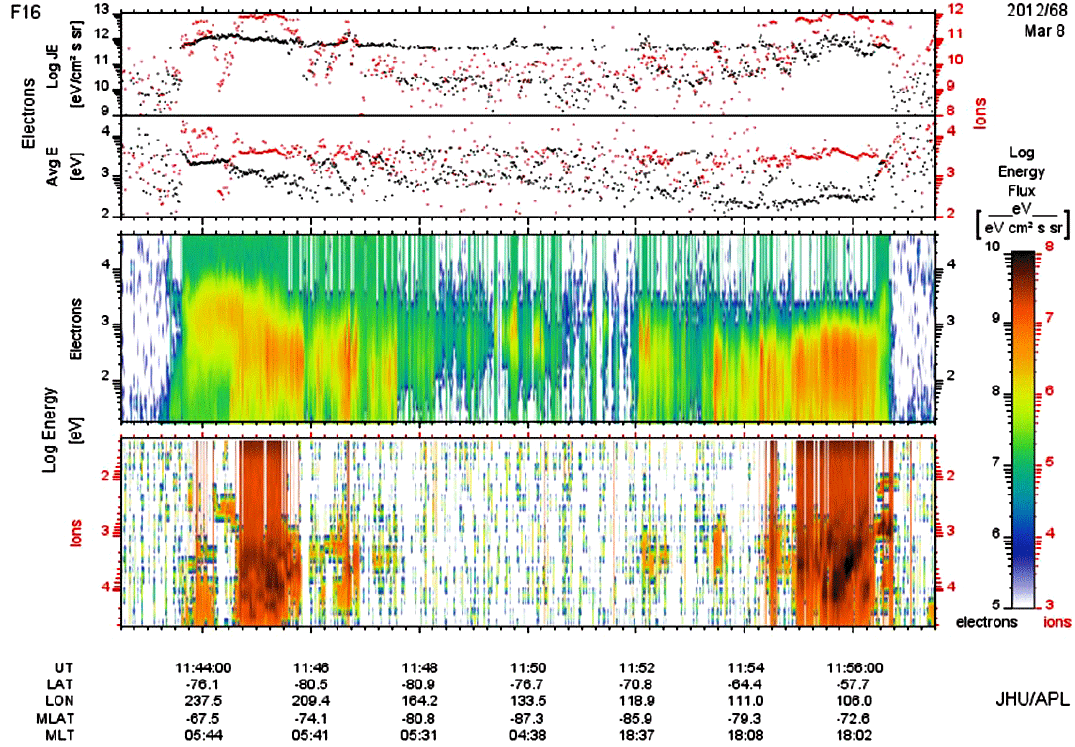
Figure 12. Precipitating particle fluxes observed by the F16 DMSP satellite during a pass over the southern auroral oval and polar